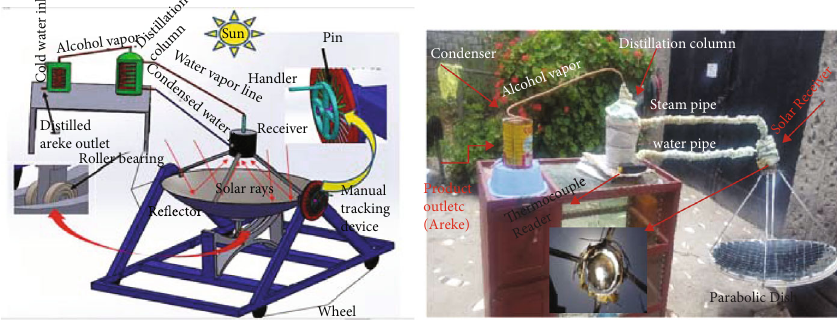
Figure 3: Schematic diagram (a) and experimental setup (b) of solar thermal local “ Areke ” Distillation system. Table 1: Speci fi cation of parabolic solar dish collector. Sr.